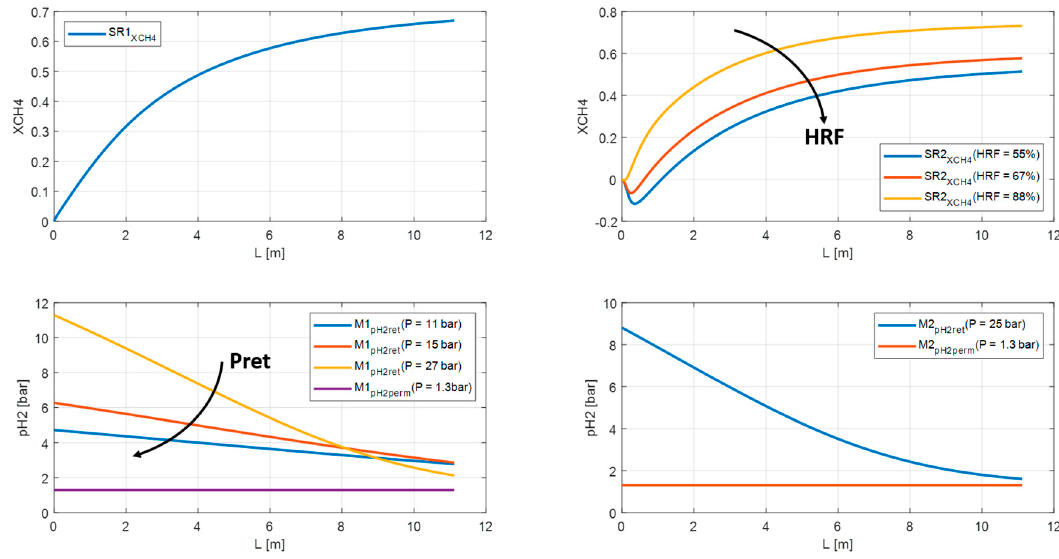
Figure 16. Methane conversion and HRF in RMM at different pressure on retentate side for M1 and M2.